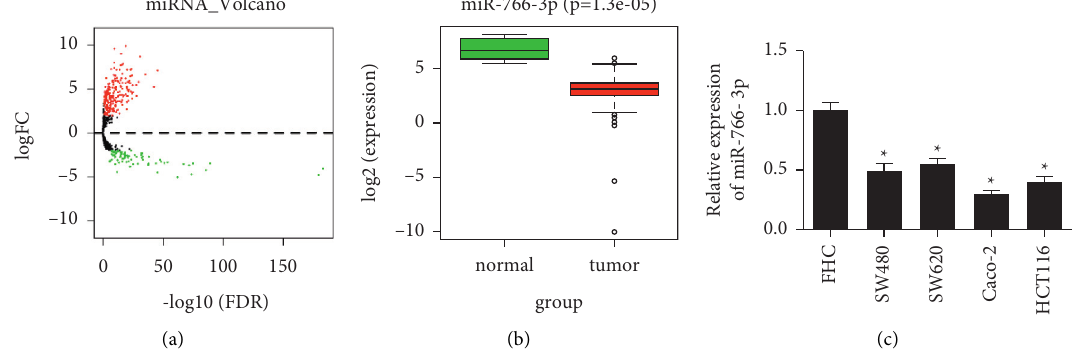
Figure 1: MiR-766-3p is less expressed in colon cancer cells. (a) Volcano map of DEmiRNAs in the TCGA database (red dots, prominently upregulated DEmiRNAs, and green dots, significantly downregulated DEmiRNAs). (b) Box plot of the miR-766-3p level in TCGA (green box, normal, and red box, tumor). (c) MiR-766-3p level in the normal colon epithelial cell line FHC and colon cancer cell lines SW480, SW620, Caco-2, and HCT116. ∗ P < 0 .